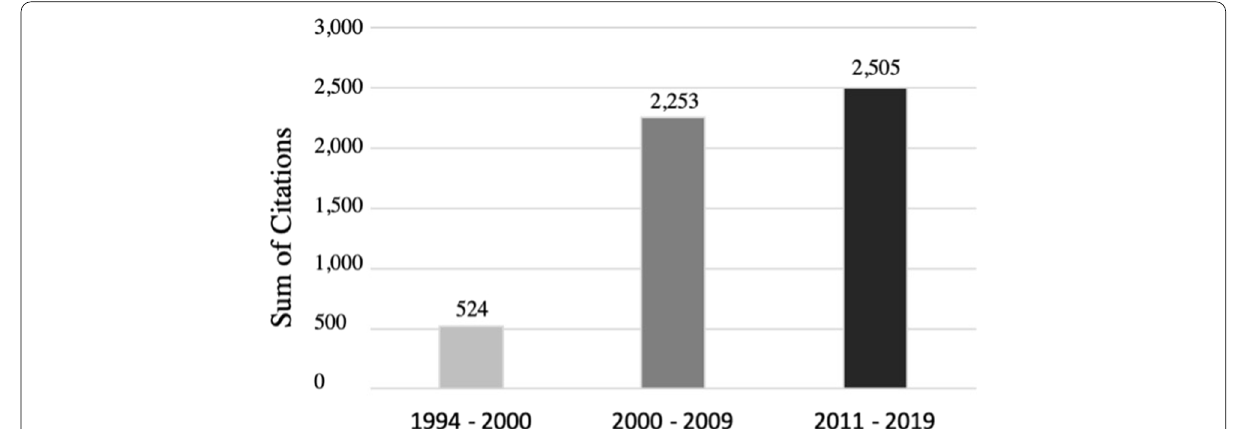
Fig. 5 Sum of citations of all articles published according to the last three decades